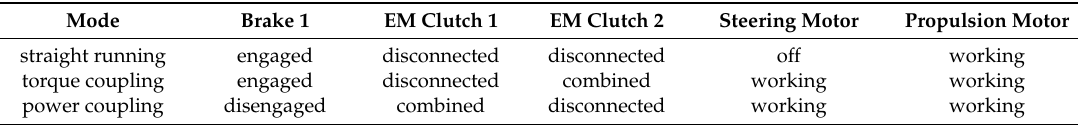
Table 4. Coupling mode and the operation of each